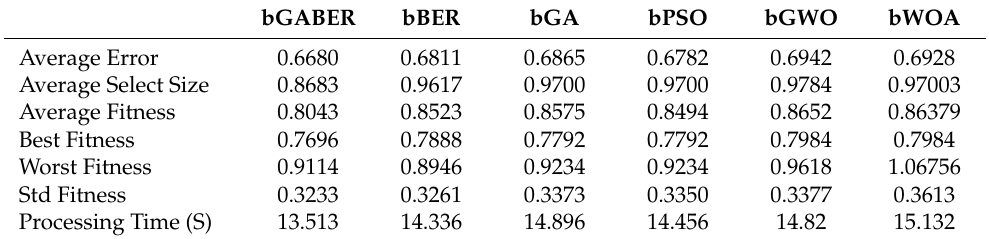
Table 5. Evaluation of the proposed feature selection method using the wind speed dataset.